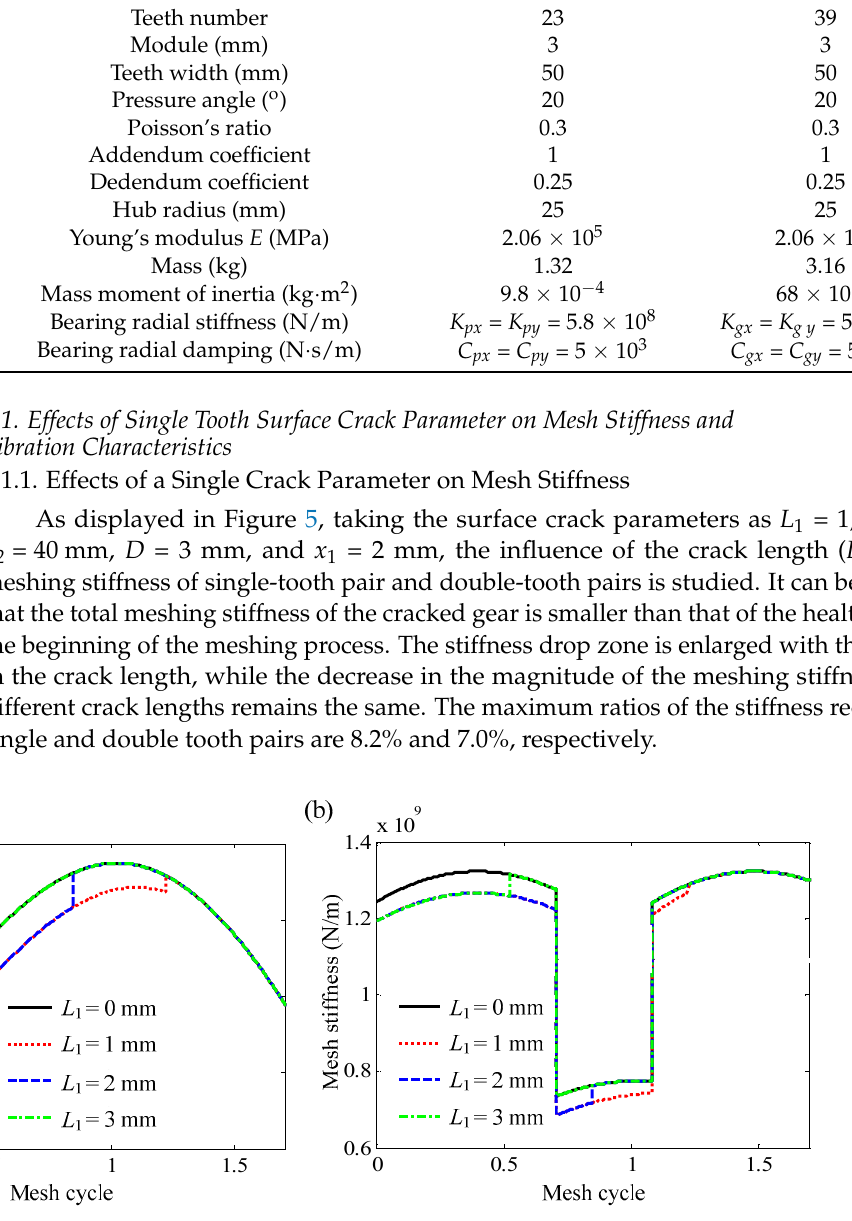
Figure 5. Effects of surface crack length on meshing stiffness: ( a ) single ‐ tooth pair, ( b ) double ‐ tooth pairs.